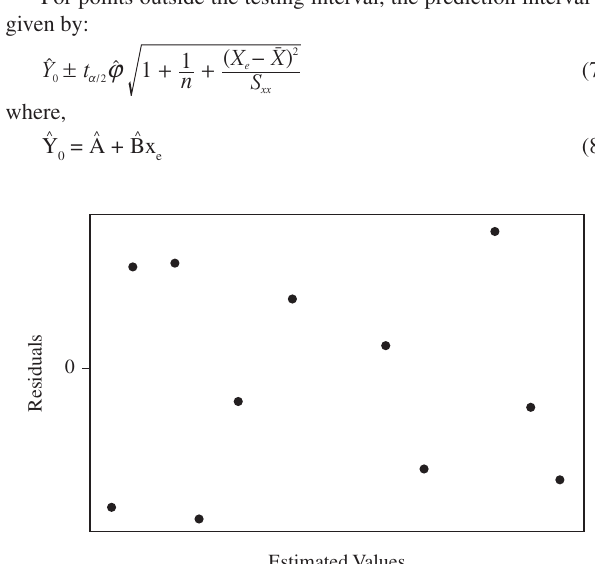
Figure 1. Example of a graph of residuals ( ^ e ( ^ Y ) when the regression model is adequate. i